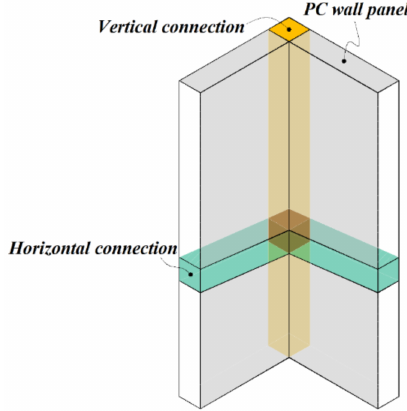
Figure 2. Horizontal and vertical connection in PC wall